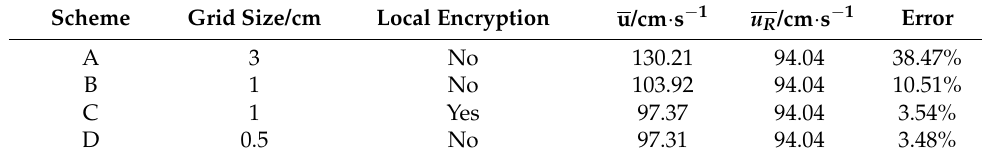
Figure 2. Calculation area of the mesh profile. Table 1. Grid irrelevance verification